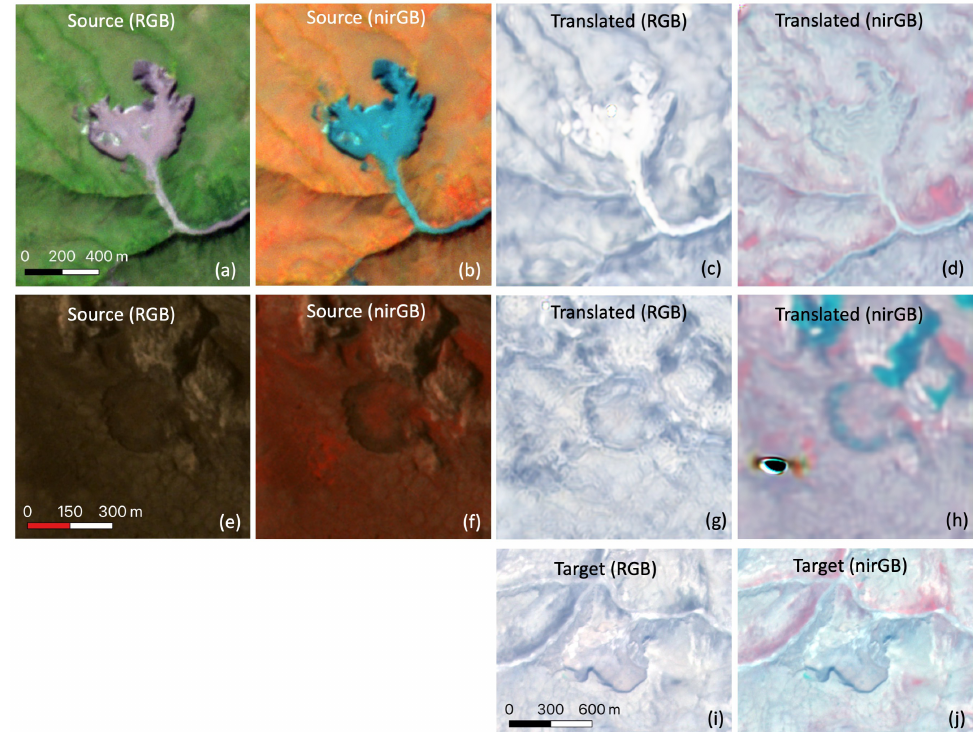
Figure 9. Sub-images from source ( a , b , e , f ) and target ( i , j ) domains, and translated sub-images ( c , d , g , h ). ( c , d ) were translated from ( a , b ), respectively, and ( g , h ) were translated from ( e , f ), respec- tively. The source domains are from two study areas (Willow River and Fosheim Peninsula) and the target domain is from the Jesse